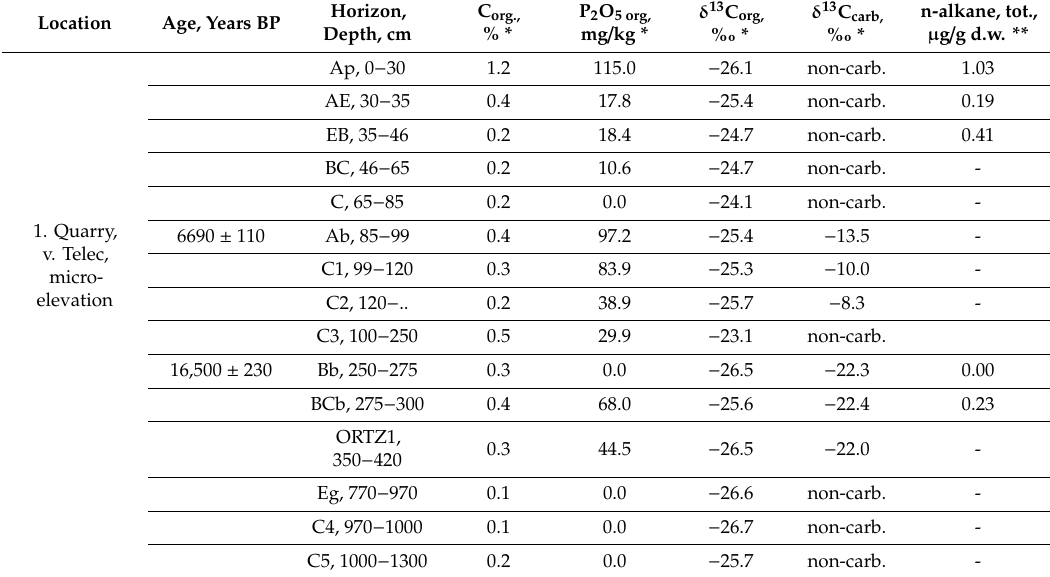
Table A1. Characteristics of organic matter